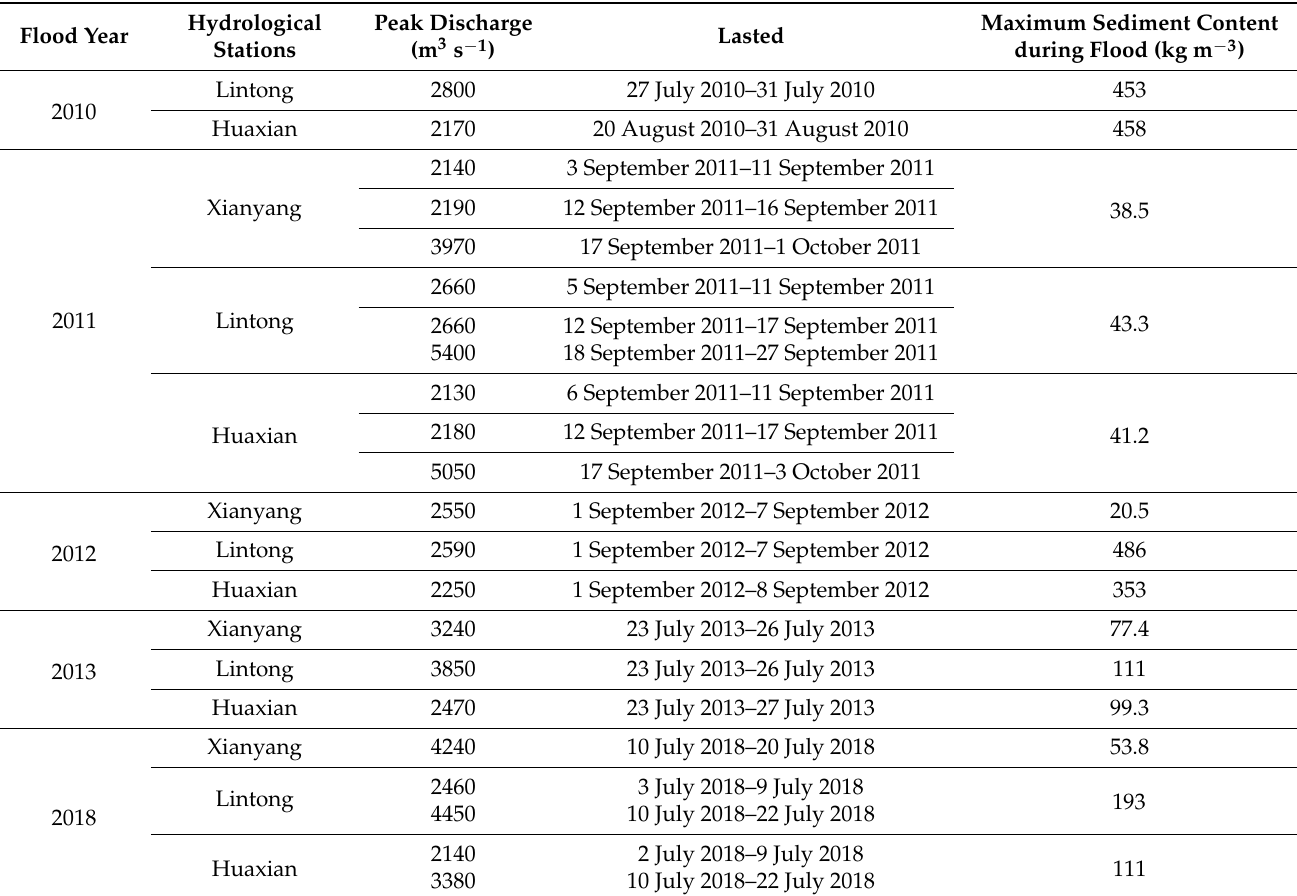
Table 4. Typical flood main streamflow and sediment